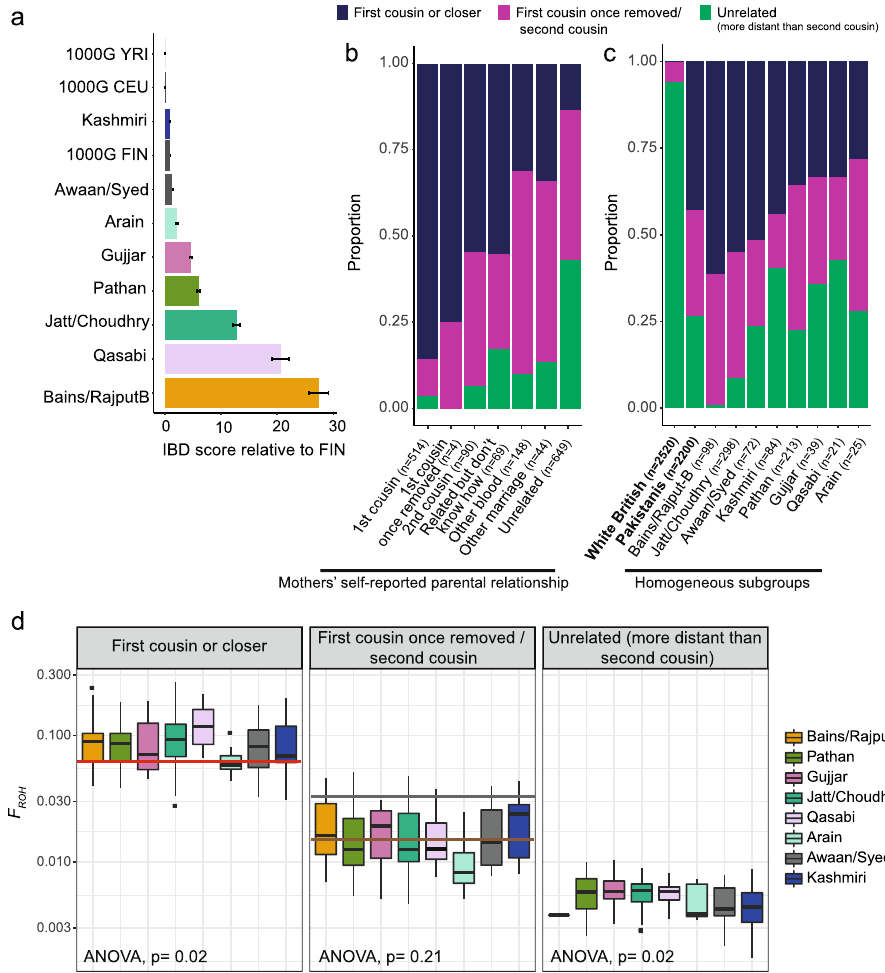
Fig. 4 Effect of endogamy and consanguinity on IBD sharing and ROH patterns in BiB Pakistani subgroups. Note that these are the homogeneous subgroups de fi ned using the fi neSTRUCTURE clusters. a IBD scores were calculated as the average total length of IBD segments between 5 and 30 cM shared between individuals from the indicated group ( n = 964 independent samples), standardised by the value for the 1000 Genomes Finns (FIN). The error bars indicate the IBD score standard error. YRI Yoruba, CEU Western Europeans. b , c Stacked bar plots showing inferred parental relatedness b in the Pakistani mothers broken down by self-reported parental relatedness or c in all white British versus all Pakistani mothers, and in Pakistani mothers broken down by subgroup. d Boxplots showing the fraction of the genome in regions of homozygosity ( F ROH ) broken down by subgroup and inferred degree of parental relatedness ( n = 850 independent samples). In each boxplot the centre is equal to the median, the upper and lower bounds of the box correspond to 25th and 75th percentiles and the whiskers represent 1.5 times the inter-quartile range (IQR) from the bounds of the box. Outliers are represented as points. Lines indicated expected F ROH for individuals with parents who are fi rst cousins (red), fi rst cousins once removed (grey) and second cousins (brown). The two-way ANOVA tests whether F ROH differs between the